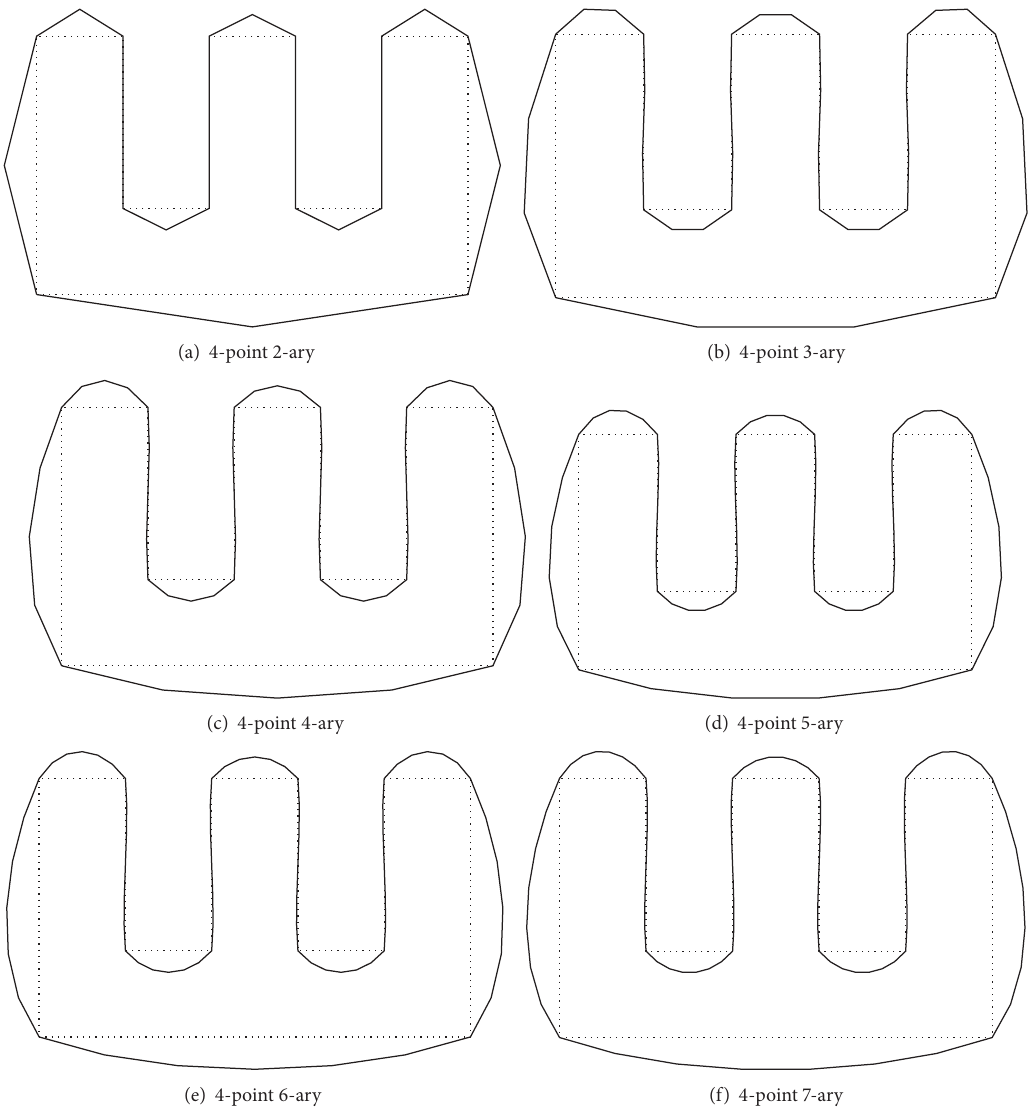
Figure 4: Comparison of the limit curves generated by proposed 4-point 2-ary, 3-ary, 4-ary, 5-ary, 6-ary, and 7-ary interpolating subdivision schemes at 1st subdivision